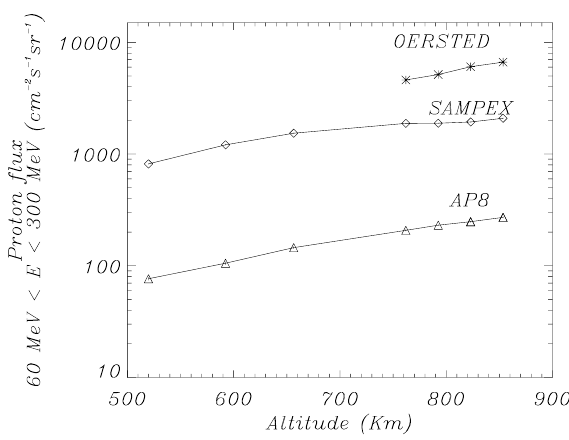
Fig. 8. Flux of energetic protons as a function of altitude from Oer- sted/CPD (uncorrected, from April 1999 data) measurements com- pared to SAMPEX/PSB97 and AP8-MAX predictions. The typical statistical error on proton fluxes are 10% and the systematic error was considered